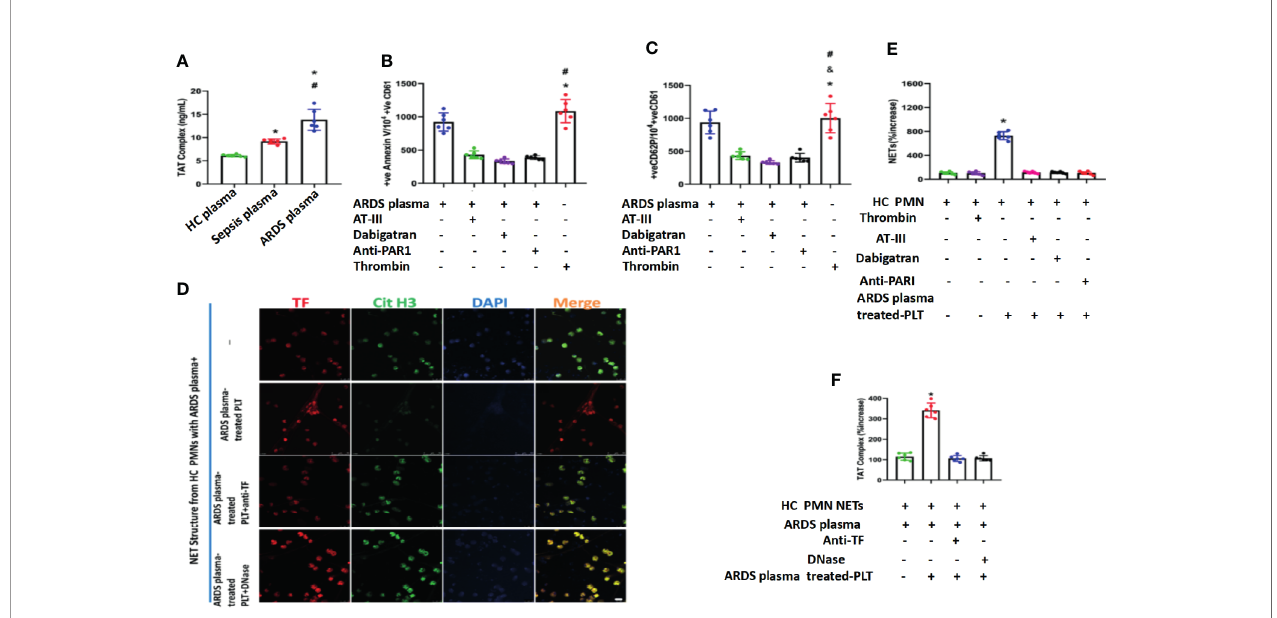
FIGURE 6 | Thrombin in plasma from ARDS is responsible for platelet activation and subsequent NET generation. (A) Thrombin levels in plasma obtained from 3 different groups as assessed by TAT complex enzyme-linked immunosorbent assay. Fluorescence-activated cell sorting analysis of Annexin V (B) and CD62P (C) on control platelets treated with plasma from ARDS patients in the presence or absence of thrombin (antithrombin III or dabigatran) and PAR-1 signaling inhibitors. Recombinant thrombin was used as a positive control (n=6). (D) Thrombin levels in control plasma incubated with isolated NET structures from control PMNs stimulated as in ARDS plasma- and ARDS plasma-treated PLTs. (E) The NET increase was tested with a myeloperoxidase-deoxyribonucleic acid complex enzyme- linked immunosorbent assay derived after stimulation of control PMNs with plasma from ARDS and control platelets pretreated with ARDS in the presence or absence of thrombin inhibitors (antithrombin III or dabigatran) (n=6). (F) Anti-tissue factor antibody was used to neutralize tissue factor-mediated thrombin generation. DNase I was used for neutrophil extracellular trap scaffold degradation (n=6). P < 0.05 (*), P < 0.05 ( # ) and P < 0.01 ( & ) compared to baseline healthy controls and the sepsis group or ARDS group were considered statistically signi fi